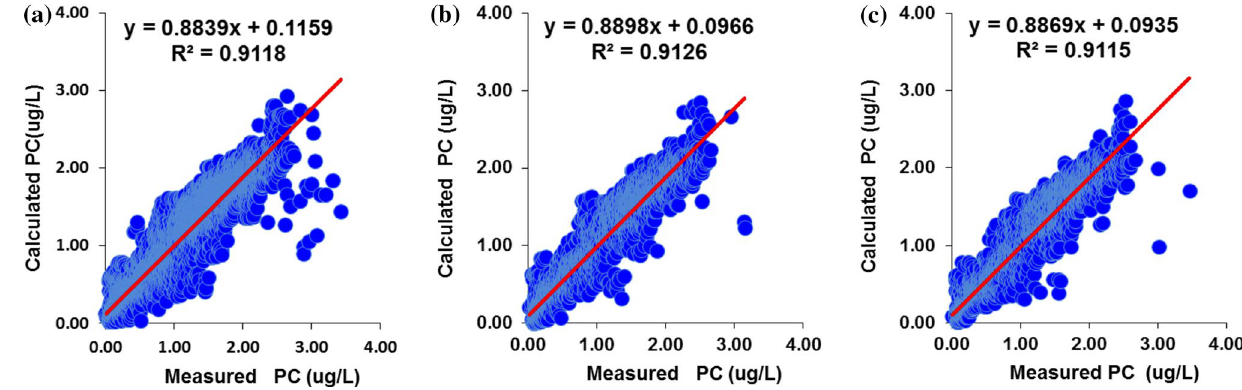
Fig. 5 Scatterplots of estimated versus measured values of PC for ANFIS_SC (M1) model: a training, b validation and c test data—Station ID: 06892350